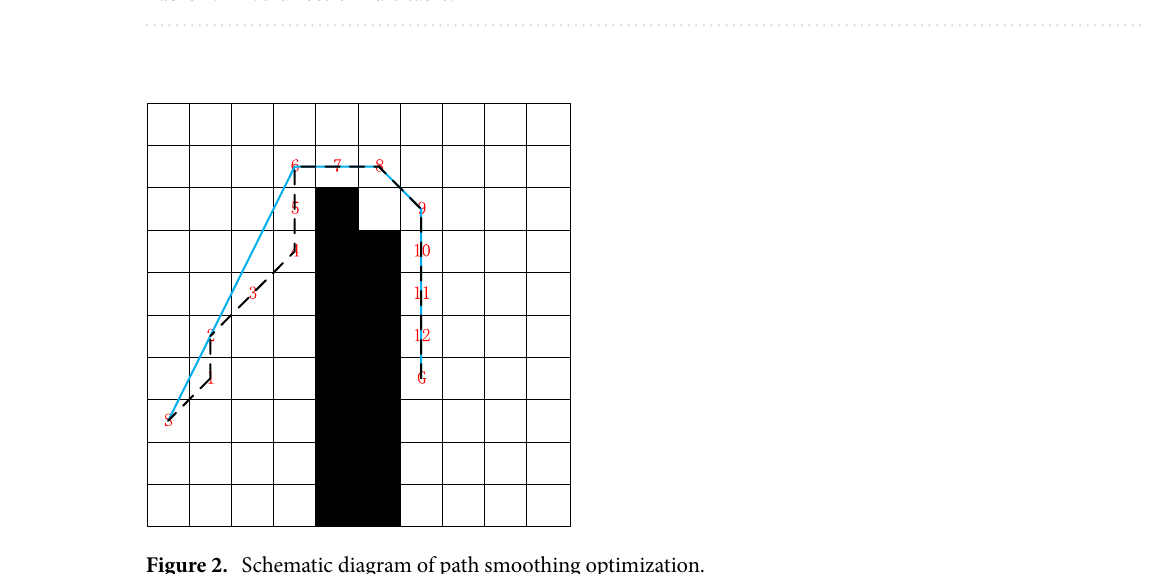
Table 2. Five-direction rule table.